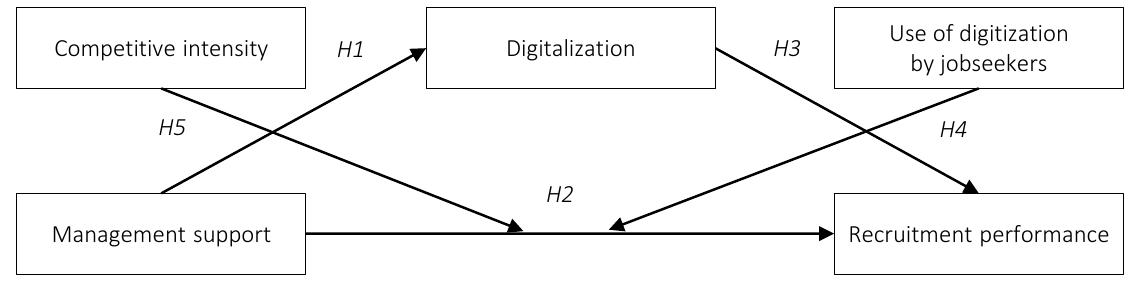
Figure 1. Research